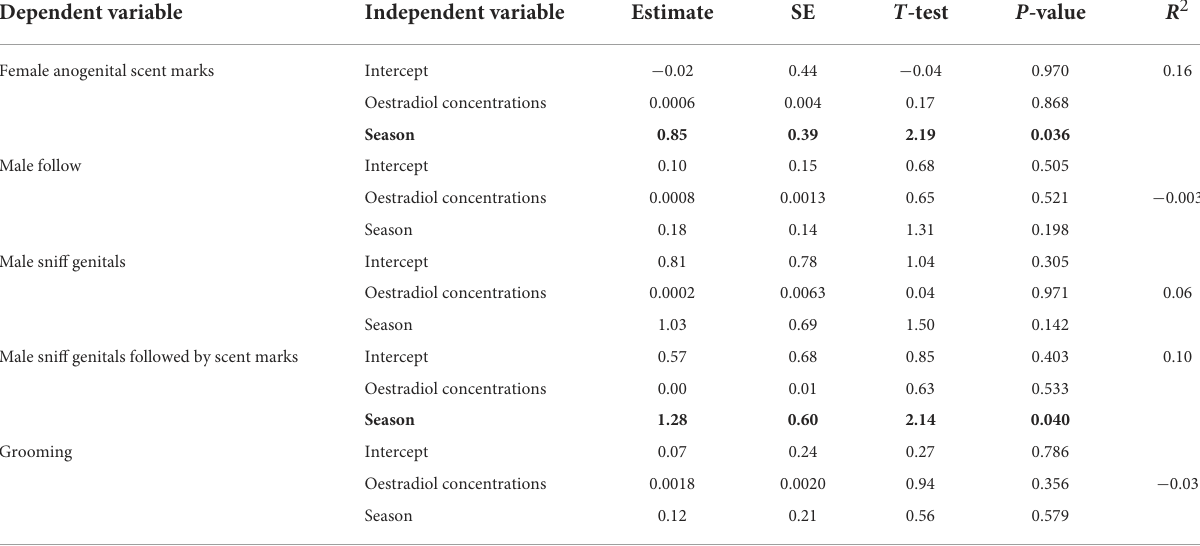
TABLE 4 Summary of the linear regression results testing the effect of female oestradiol concentrations and periods (breeding vs. non-breeding) on female and male behaviours.